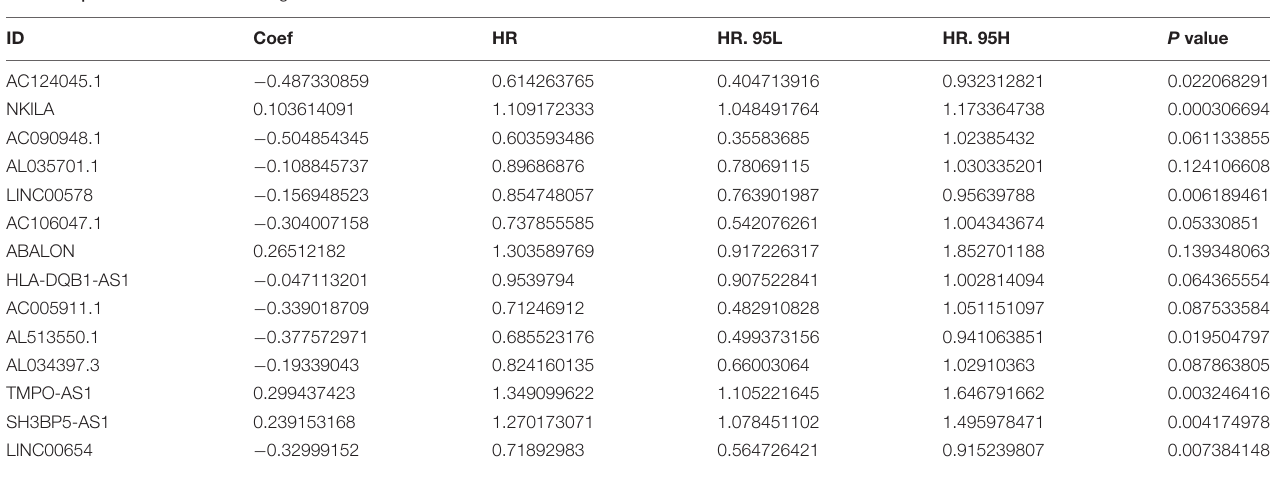
TABLE 2 | The 14 m5C-Related Prognostic